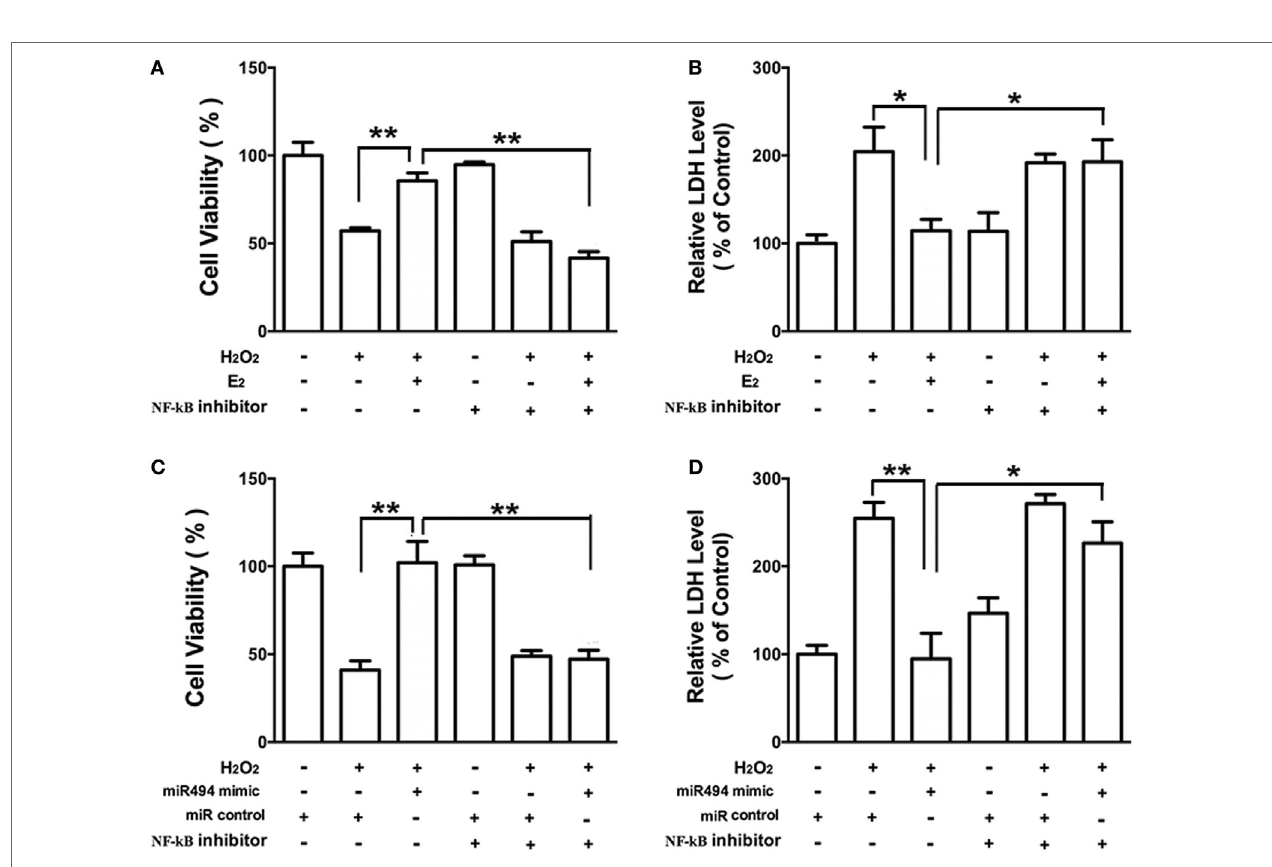
FigUre 6 | The protective effects of E 2 and miR-494 against oxidative stress in cardiomyocytes are eliminated by NF- κ B inhibitor. (a,B) H9c2 cells were incubated with E 2 (10 nmol/L) in the absence or presence of NF- κ B inhibitor (PDTC, 1 µmol/L) for 24 h. Cells were then exposed to H 2 O 2 (200 µmol/L) for 4 h. Overall cell viability was assessed by MTT (a) and supernatant lactate dehydrogenase (LDH) concentration (B) . (c,D) H9c2 cells were transfected with control microRNA (miR) or mimics of miR-494 in the absence or presence of NF- κ B inhibitor (PDTC, 1 µmol/L) for 24 h. Cells were then exposed to H 2 O 2 (200 µmol/L) for 4 h. Overall cell viability was assessed by MTT (c) and supernatant LDH concentration (D) . All bar graphs represent the mean ± SEM from four independent experiments. * P < 0.05, ** P < 0.01.